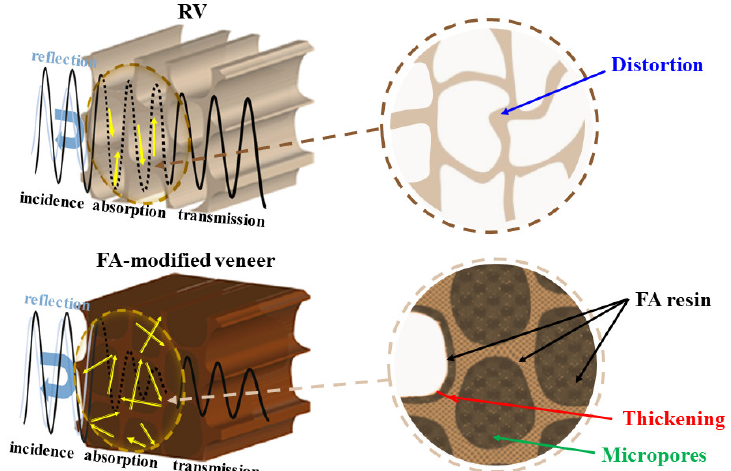
Figure 9. Sound propagation diagram of RV and the FA-modified veneers.